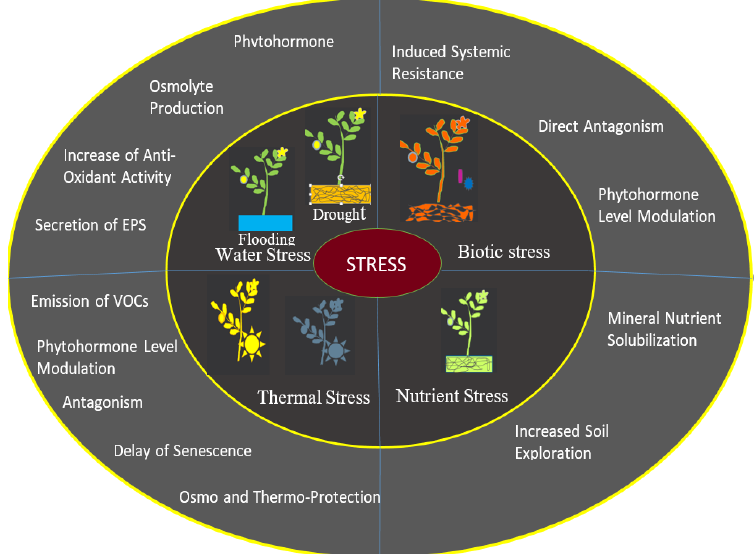
Figure 2. Climate change adaptation and soil microbiome.